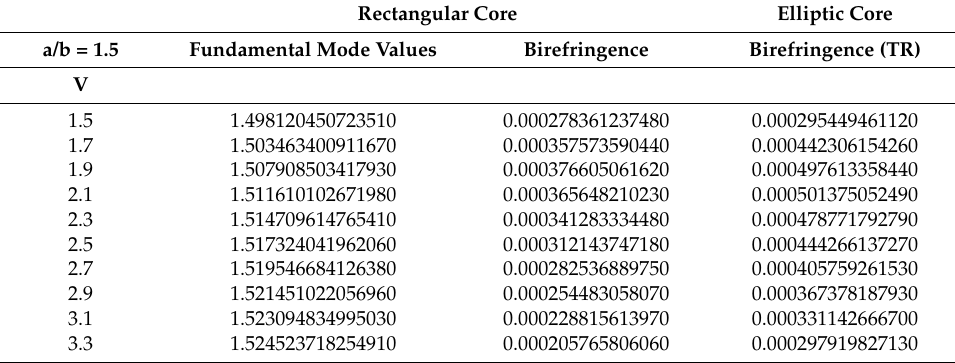
Table 7. Comparison of birefringence for elliptical and orthogonal core fibers.